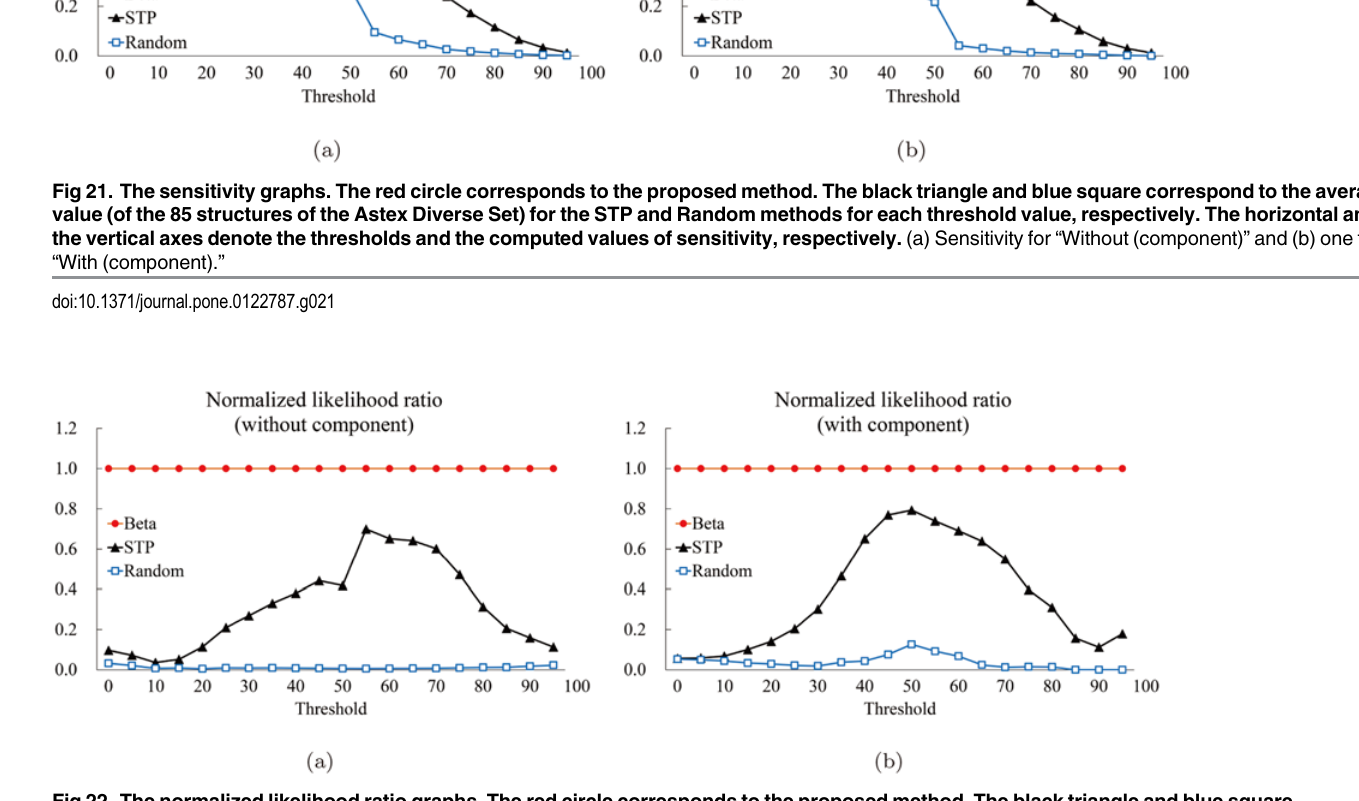
Fig 22. The normalized likelihood ratio graphs. The red circle corresponds to the proposed method. The black triangle and blue square correspond to the average value (of the 85 structures of the Astex Diverse Set) for the STP and Random methods for each threshold value, respectively. The horizontal and the vertical axes denote the thresholds and the computed values of likelihood ratio, respectively. (a) The normalized likelihood ratio for “ Without (component) ” and (b) one for “ With (component). ”